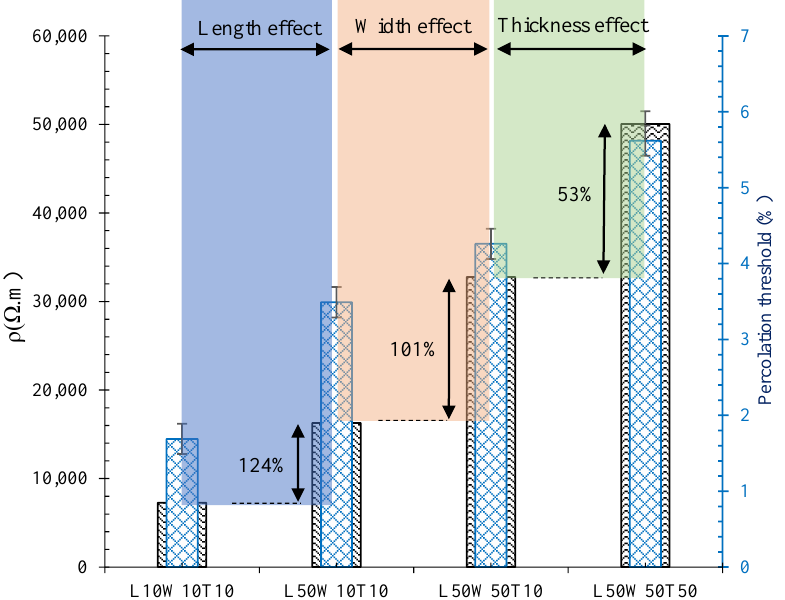
Figure 12. Electrical resistivity of specimens reinforced with hybrid CNT/GNP at the percolation threshold content.